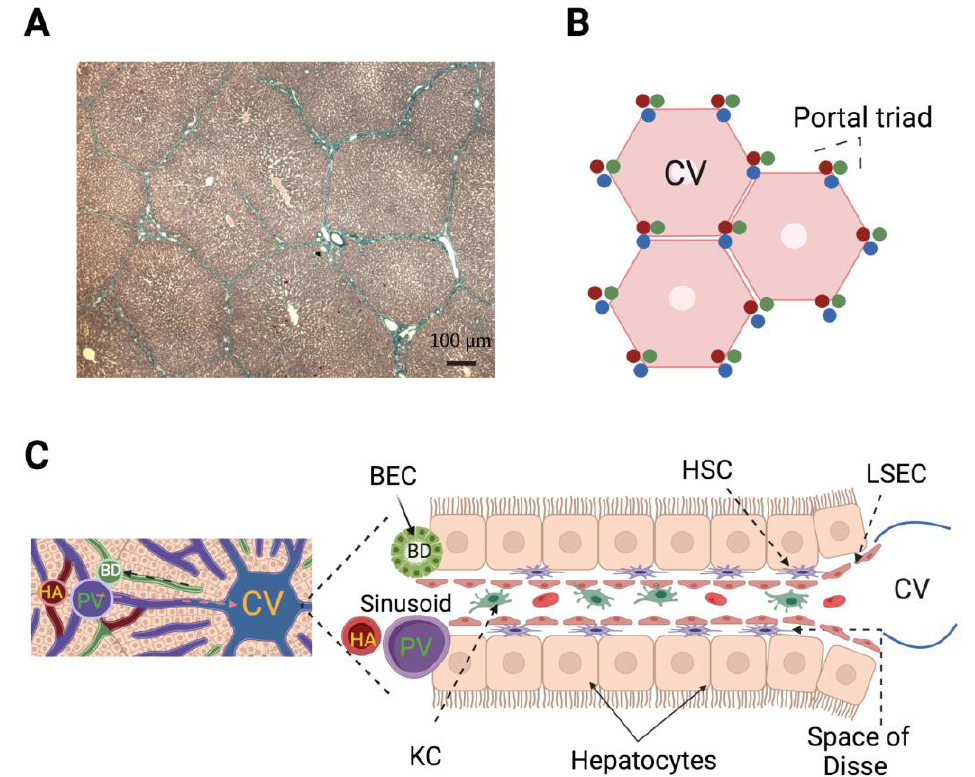
Figure 3. Hepatic lobules represent the functional unit of the liver. ( A ) Masson trichrome-stained histological section showing the polygonal shape of hepatic lobules from pig (4X). ( B ) Representation of the human hepatic lobule according to the vascular network model based on fluid mechanics where the hexagonal shape was determined to be optimal to avoid pressure losses because flow resistances are minimal. Note that each portal triad makes contact with three lobules. ( C ) Left: Liver lobule close-up; the direction of blood (orange arrow) and bile (black arrow) flows are indicated. Right: Hepatic microcirculation composed of capillaries (sinusoids) lined by liver sinusoidal endothelial cells (LSEC) where blood flows of the hepatic artery (HA) and portal vein (PV) converge. In the sinusoid, Kupffer cells (KC; resident macrophages of the liver) protect the liver from pathogens and produce proinflammatory cytokines after PH; KC coexist with different types of lymphocytes. On each side of the sinusoid the hepatocytes (parenchymal cells) are linearly distributed leaving a space between them and the sinusoid wall—the space of Disse—where hepatic stellate cells (HSC) are located. The HSC under quiescent conditions store droplets full of vitamin A, after PH become activated, then the droplets are depleted, cells change their phenotype to a myofibroblast-like one, and contribute to regeneration at different stages. The bile duct (BD) is composed by biliary epithelial cells (BEC, or cholangiocytes). The BEC share with hepatocytes the embryonic lineage from hepatoblasts, and importantly, under extreme conditions BEC dedifferentiate to liver progenitor cells, which in turn differentiate into hepatocytes [18]. The LSEC, KC, HSC, BEC, and lymphocytes are included in the group of non-parenchymal cells.